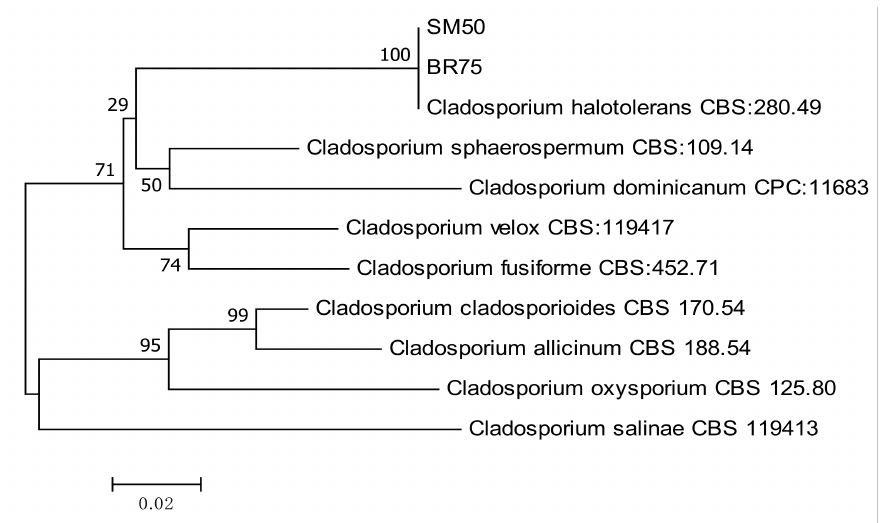
Figure 9. Maximum likelihood tree inferred from combined sequences of ITS and ACT of C. halotolerans isolates from C. castaneus spines with bootstrap values higher than 50% are shown next to the